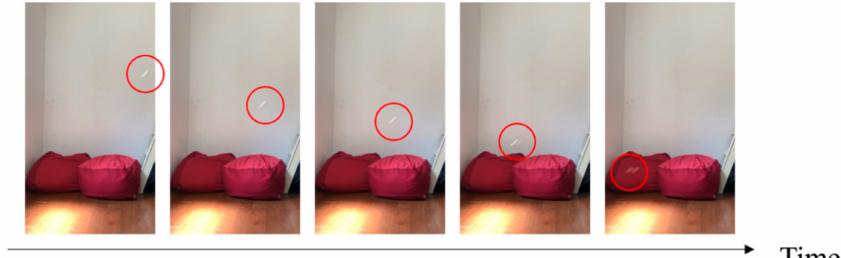
Figure 4. Falling test of the model of the Alsomitra.